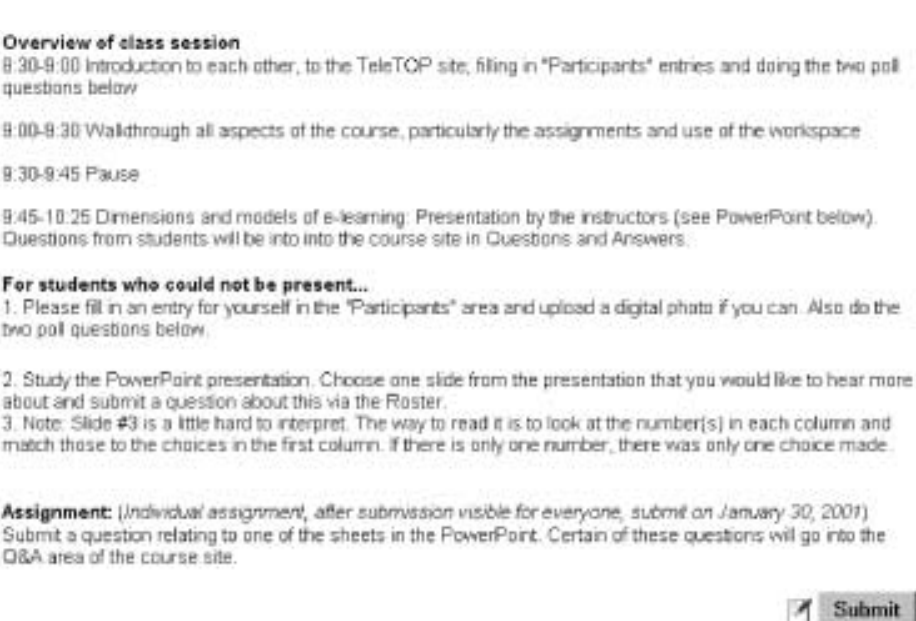
Figure 6. Example of flexibility in pedagogic approach related to attending a session Language to be used during the course